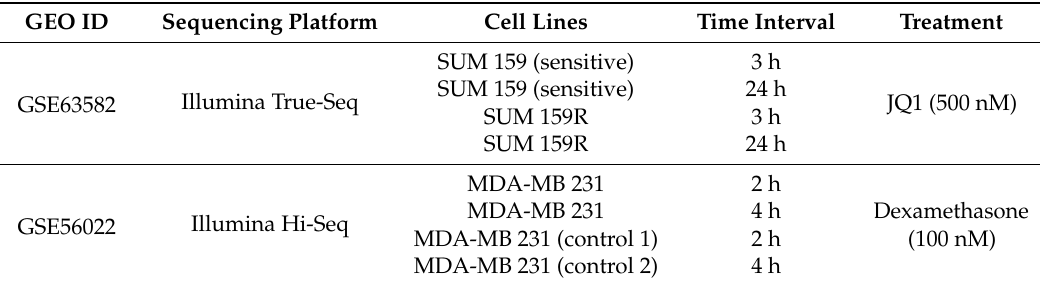
Table 6. RNASeq datasets used for the study and their characteristics. GEO ID Sequencing Platform Cell